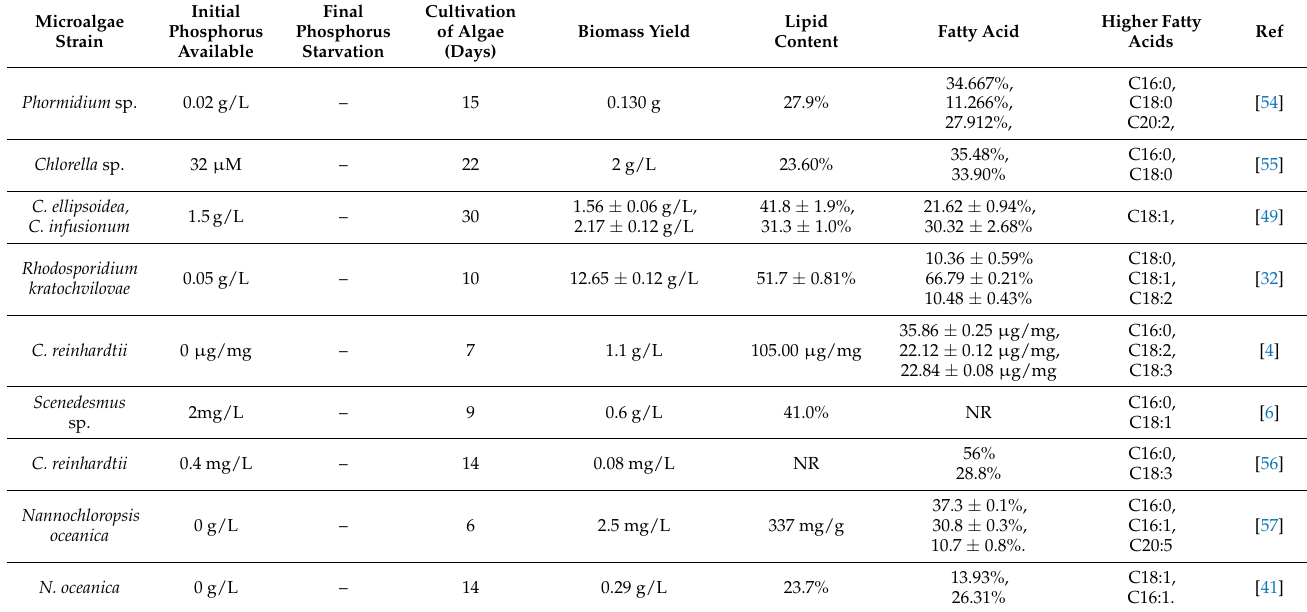
Table 4. Effect of phosphorus availability and starvation conditions on biomass yield, lipid content and fatty acids in algae. Microalgae